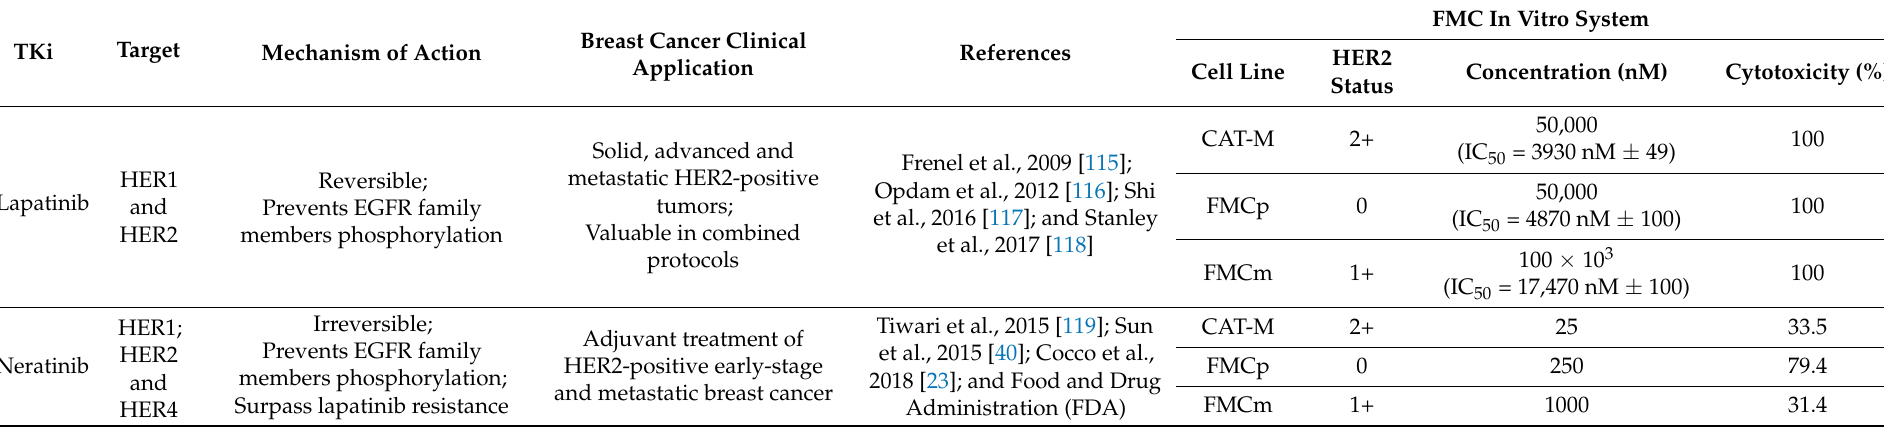
Table 4. Tyrosine kinase inhibitors (lapatinib and neratinb) presented valuable cytotoxic effects in the FMC in vitro models, suggesting a conserved mechanism of action [10].